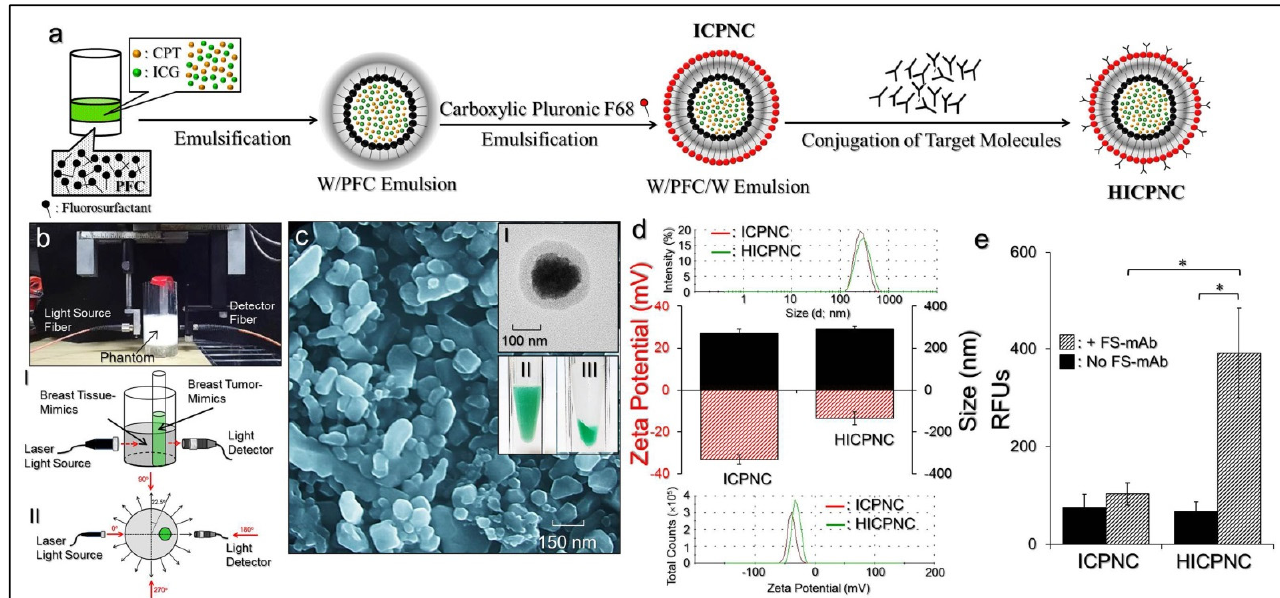
Figure 1. Assessment of physicochemical properties of the ICPNCs and HICPNCs. ( a ) The ICPNCs were synthesized through double emulsification processes using polyethoxylated fluorosurfactant and CT-F68 as the emulsifiers. The HICPNCs were obtained after conjugation with anti-HER2-mAb on the ICPNC surface. ( b ) Photograph of the phantom setup using 1S-1D scanning platform. The schematic drawings I and II display the relative positions of the BTiM, BTuM, laser light source, and light detector from side (I) and top (II) views, respectively. ( c ) SEM image of the ICPNCs at 15,000× magnification. The inset photographs exhibit the TEM image (20,000×) of the ICPNC (I) and the real appearance of the ICPNC sample before (II) and after (III) centrifugation. ( d ) Size and surface charge ( ζ —potential) distribution profiles of the ICPNCs and HICPNCs measured by DLS. Values are mean ± s.d. ( n = 3). ( e ) Verification of the presence and bioactivity of anti-HER2-mAb on the ICPNC surface. The intensity of fluorescence expressed from each group was measured by spectrofluorometry performed with 488/525 nm of excitation/emission wavelength and was quantitatively represented by RFUs. Values are mean ± s.d. ( n = 3). * p < 0.05.